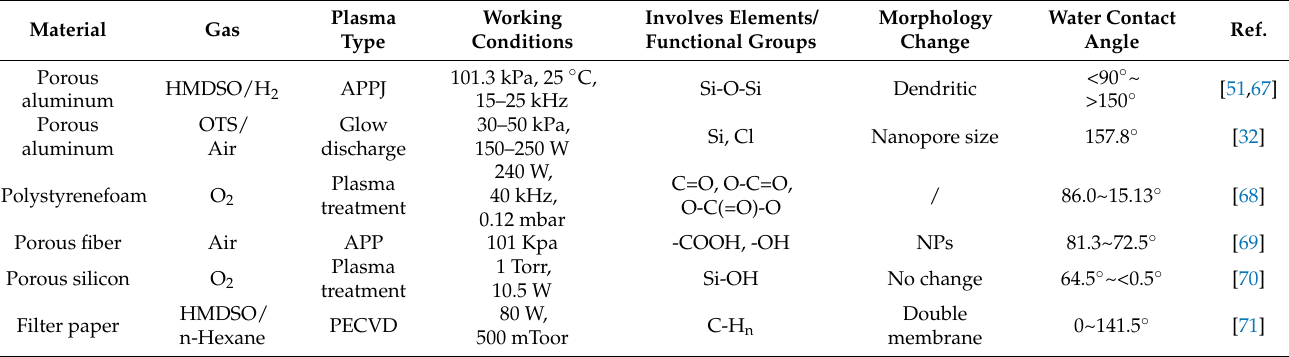
Table 2. Plasma treatment of porous